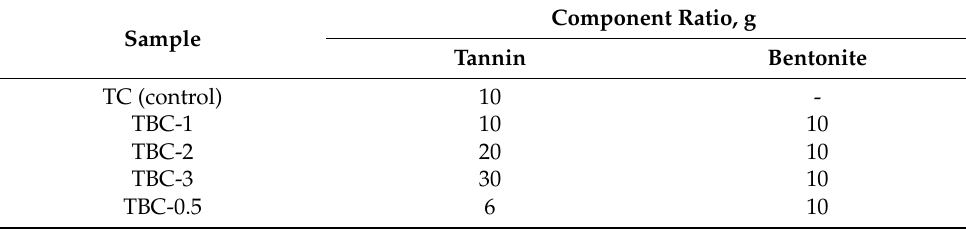
Table 1. The ratios of the initial components used to prepare materials.